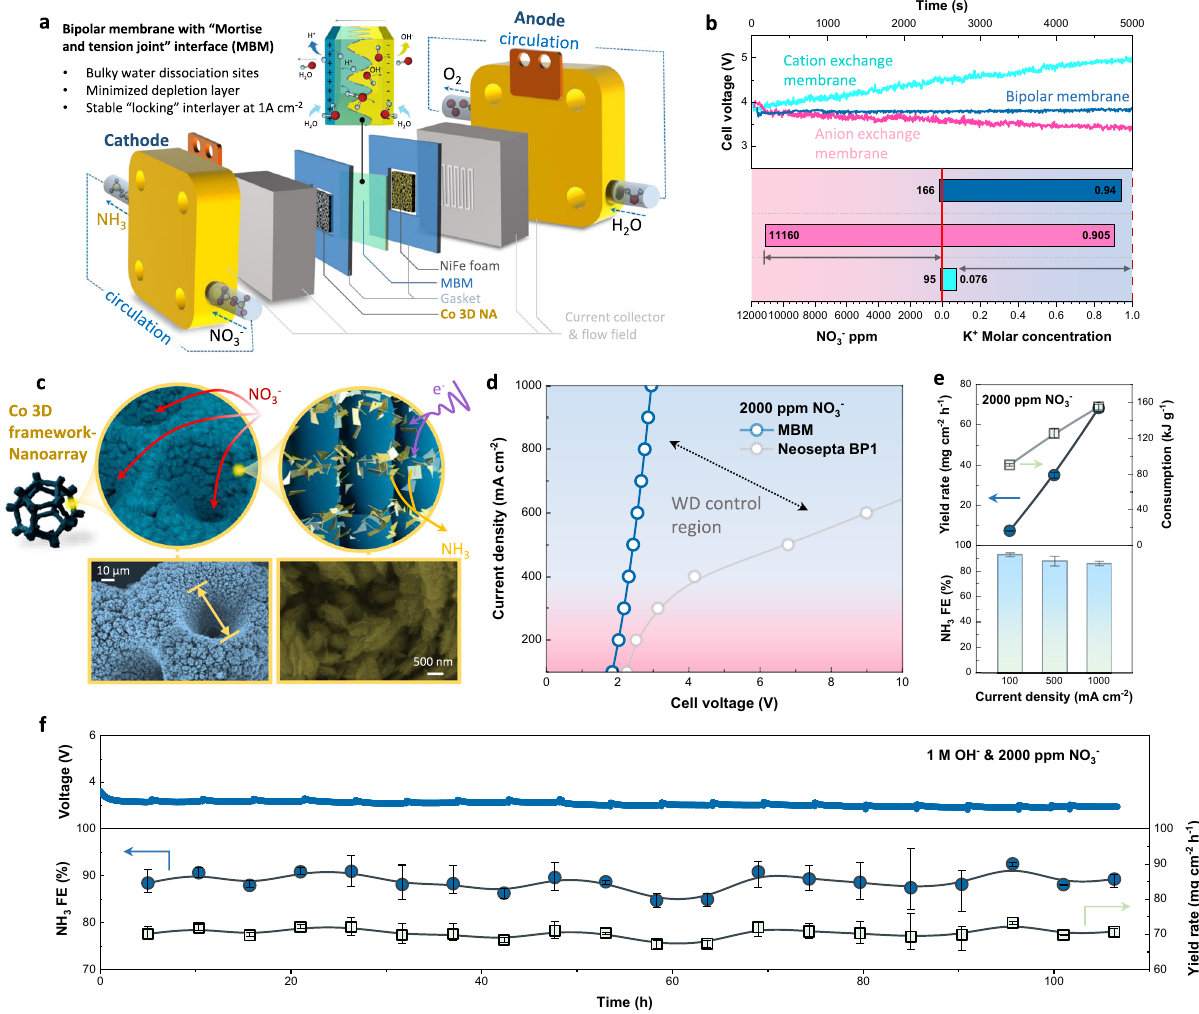
Fig.5|BipolarmembraneNH 3 electrosynthesiswitha fl owreactor.a Schematic ofbipolarmembranereactorforNH 3 electrosynthesisin fl owmode. b Ionicbalance comparation of continuous NH 3 electrosynthesis with cation exchange membrane (Na fi on 115, aqua), anion exchange membrane (Selemion DSV, pink), and bipolar membrane(MBM,mazarine)at1Acm − 2 .Theupperplotshowscellvoltagevariation during 5000s electrolysis with different membranes; the lowerplotpresents ionic (NO 3 − and K + ) concentration change of anolyte before and after electrosynthesis with different membranes. c Schematic illustration of Co 3D framework-nanoarray as NO 3 − RR catalysts with intensi fi ed mass transfer for low NO 3 − concentration and high NH 3 yield (upper) and their SEM images of different magni fi cations (lower). d I – V curves of electroreduction NO 3 − to NH 3 in aqueous solutions with 1M KOH/